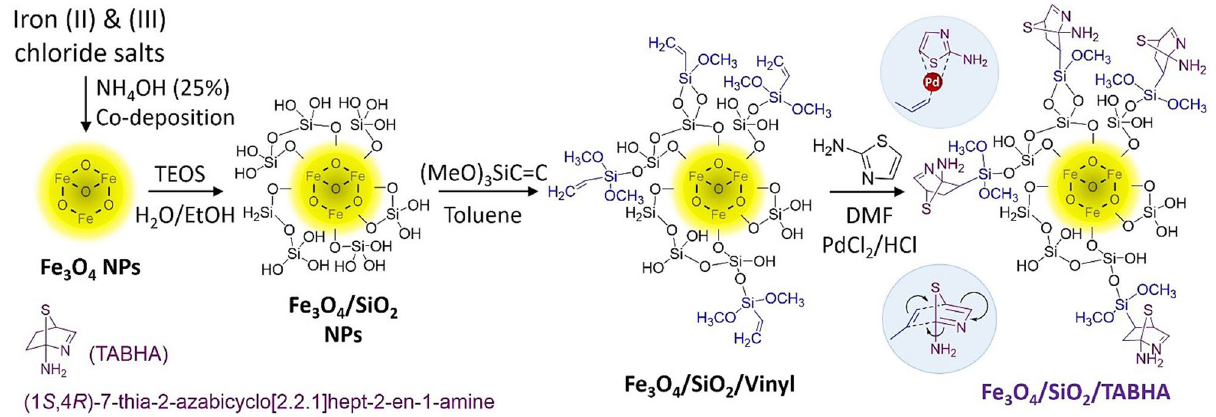
Figure 1. Schematic presentation of preparation route of Fe 3 O 4 @SiO 2 /TABHA catalytic system via Diels–Alder reaction